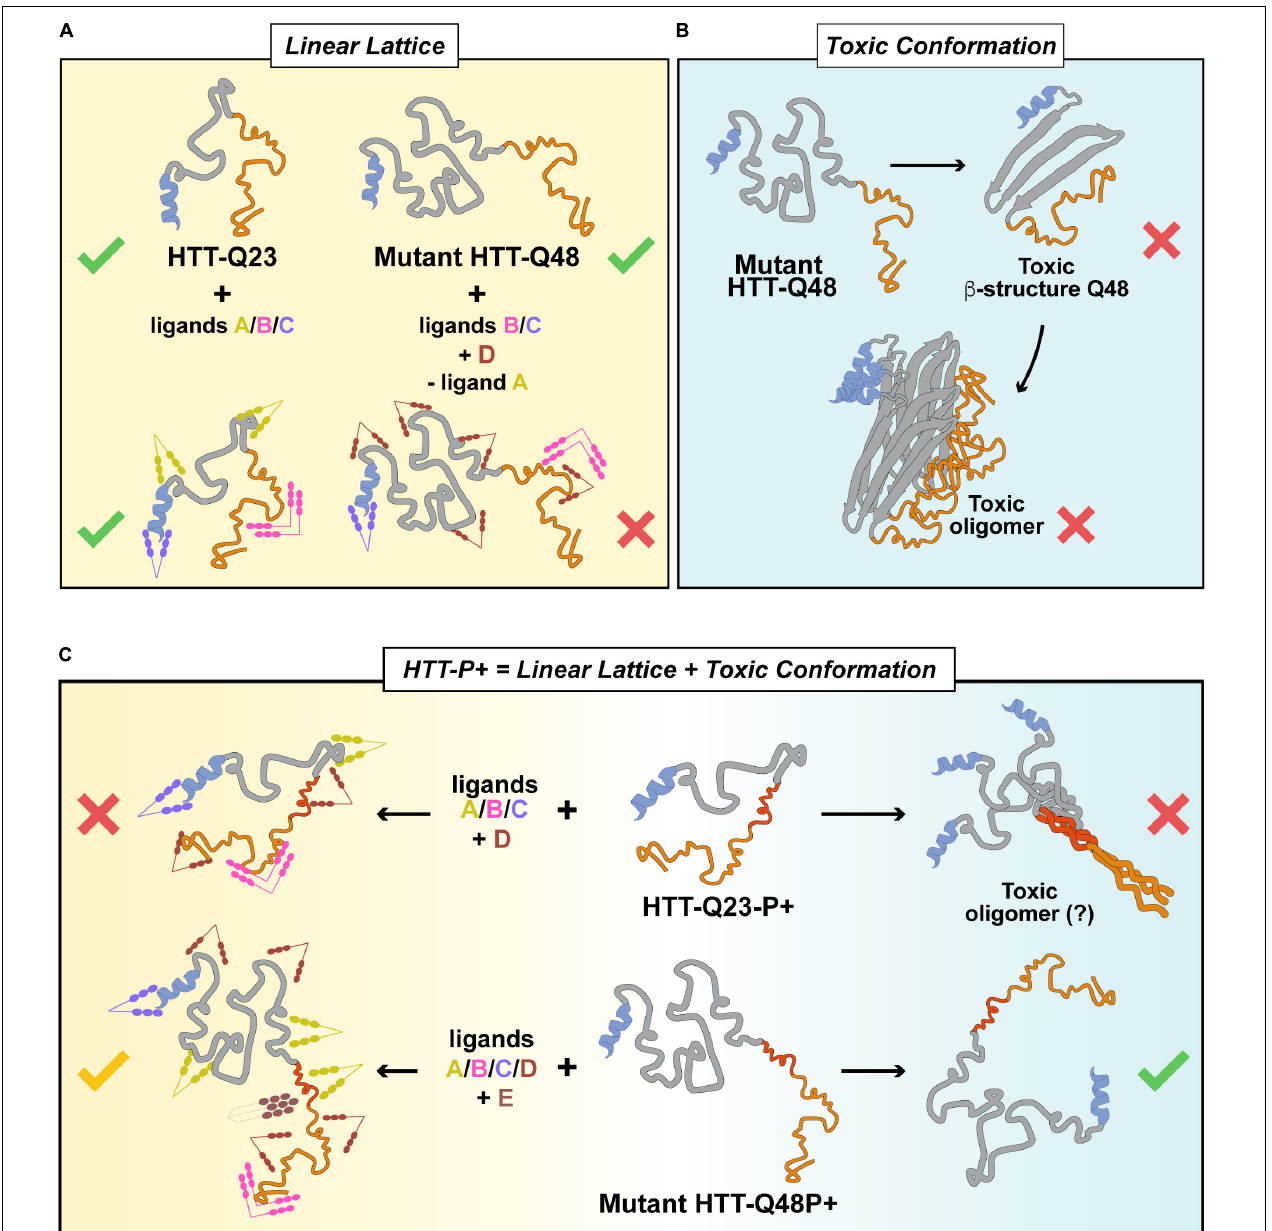
FIGURE 6 | HTTEx1 P+ behaves both according to the linear lattice and the toxic conformant models. (A) The linear lattice model of HTTEx1 postulates that mutant HTTEx1 itself is not intrinsically toxic. In the presence of Q48, but not Q23, the loss of important interactions partners or the addition of novel ones, renders the monomeric HTTEx1 toxic via a gain of toxic function. (B) Conversely, the toxic conformant model postulates that mutant HTTEx1Q48 is toxic as the expanded polyQ is capable of folding into a new β -structure that favors assembly into oligomeric species which are intrinsically toxic. (C) In the presence of an expanded proline, both models might be correct: Q23P+ is toxic in vivo as it might both increase the surface availability for ligands, and/or assume a different conformation, arising from a structural rearrangement imposed by the long polyP onto the short polyQ. For Q48-P+, the transition into toxic oligomers might be prevented by the long polyP hindering the structural rearrangement of the expanded polyQ, thus diminishing toxicity. Overall however, the interaction network of HTTEx1-P+ might also favor an increased amount of ligand binding, some of which might result in either beneficial or deleterious